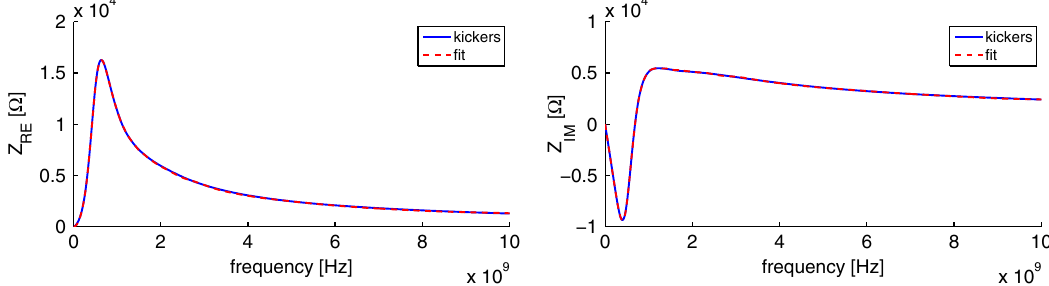
FIG. 13. Real (left side) and imaginary (right side) part of the longitudinal impedance of the PS kickers compared with a fit of 18 resonant modes.